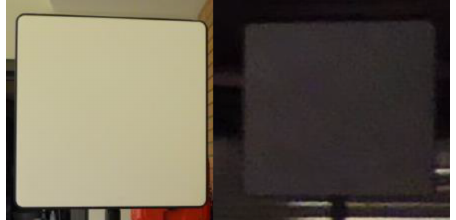
Figure 2. Spectralon targets (26 cm × 26 cm) with high reflectivity ( left ) and low reflectivity ( right